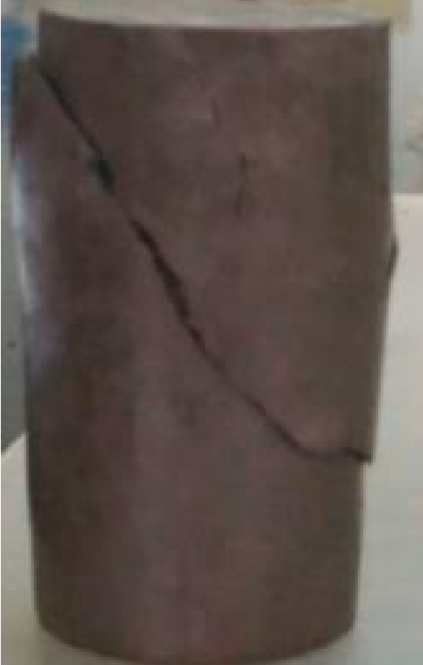
Figure 9: UCS failure of 2% waste plastic stabilized black cotton